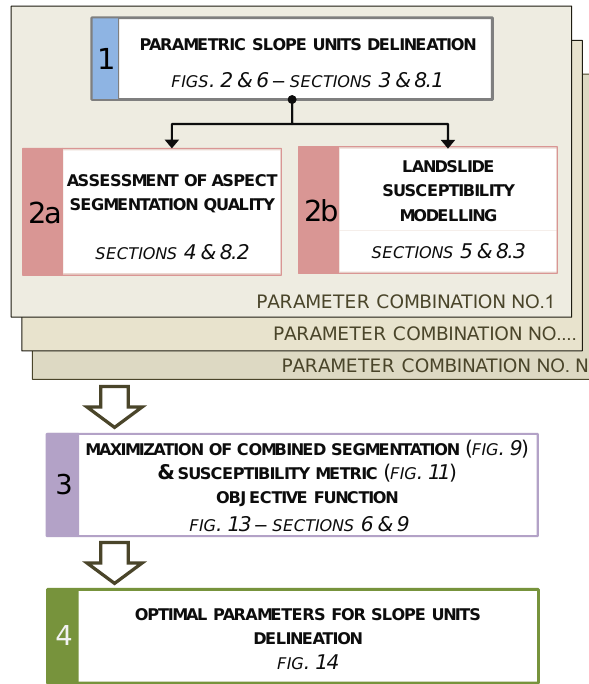
Figure 1. Logical framework for the proposed method for (1) the parametric delineation of SUs, (2a) the assessment of the quality of terrain aspect segmentation using of a proper segmentation ob- jective function, (2b) the calculation and assessment of the quality of the LS modeling using a standard AUC ROC metric, and (3) the definition and maximization of a combined objective function for (4) the determination of optimal parameters for the delineations of SUs best suited for LS modeling and